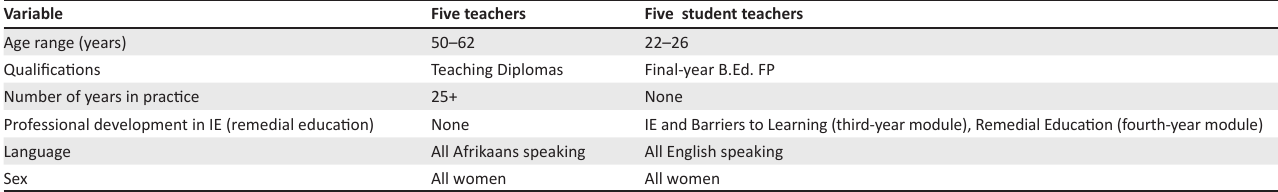
TABLE 1: Biographical information of the 10